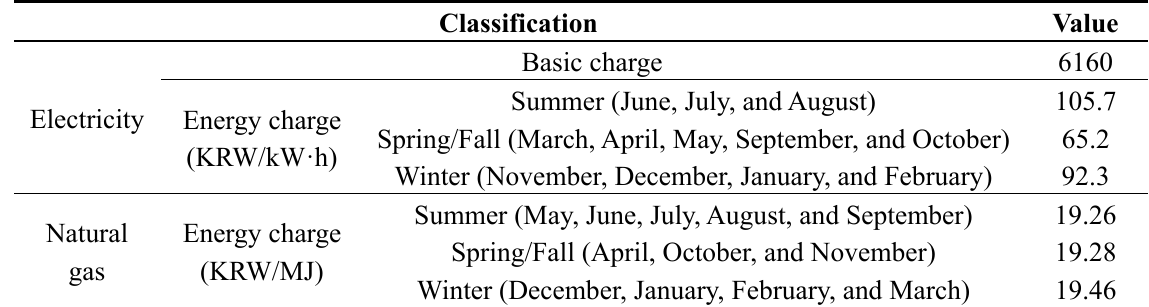
Table 2. Electricity and LNG